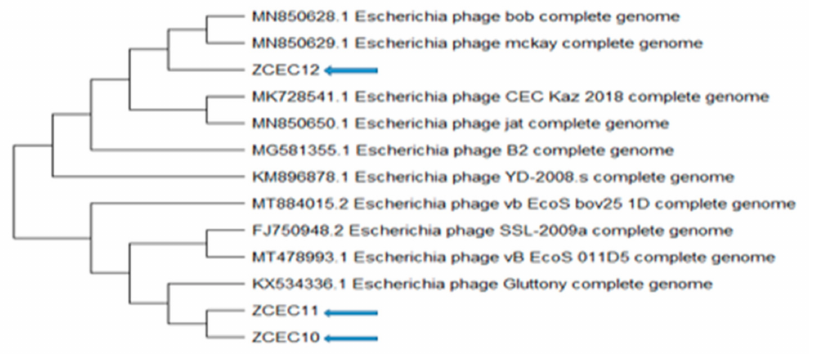
Figure 3. Phylogenetic relationships between the ZCEC10, ZCEC11, and ZCEC12 phages and BLASTN top-matched